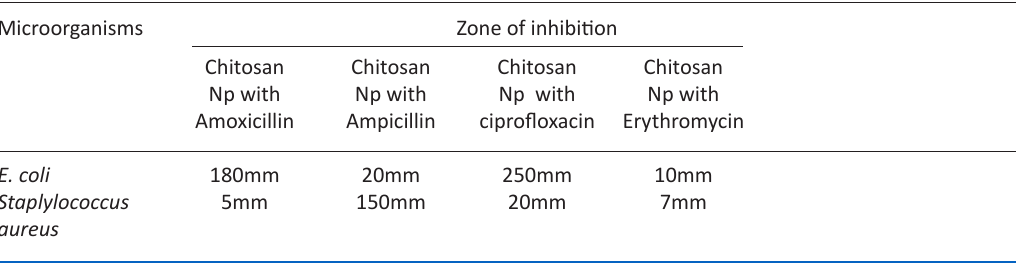
Fig. 2. FTIR spectra of the chitosan Table 2. Shows the MIC of chitosan nanoparticles conjugated with antibiotics towards th microorganisms in water and acetic acid